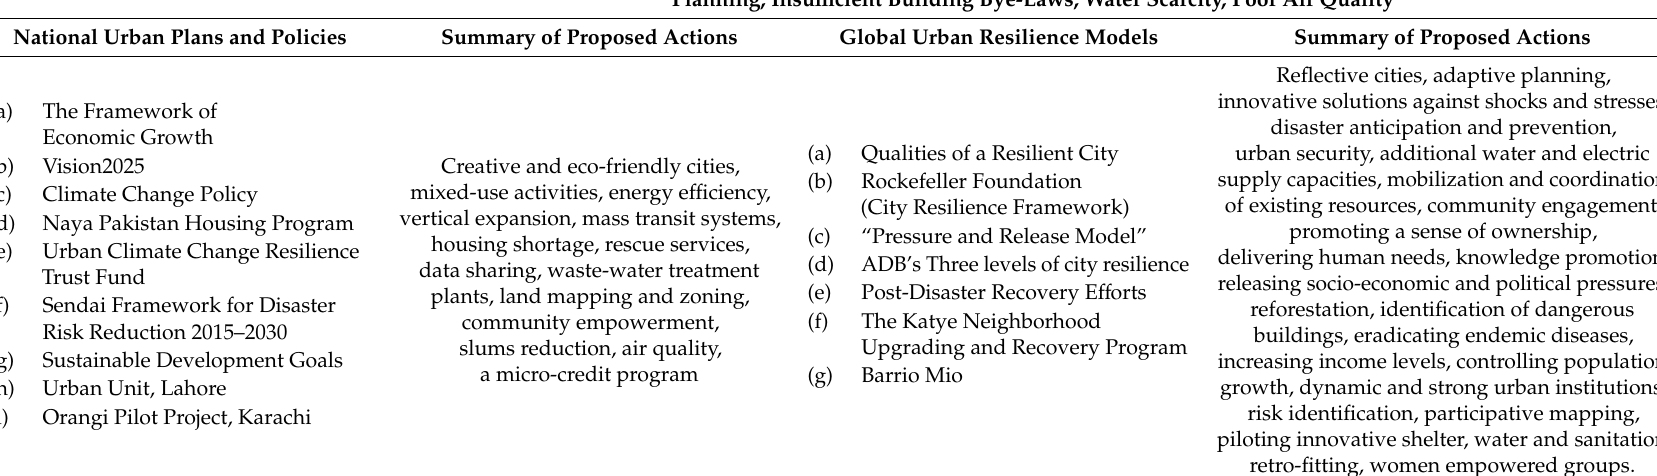
Table 1. Urban challenges and planning